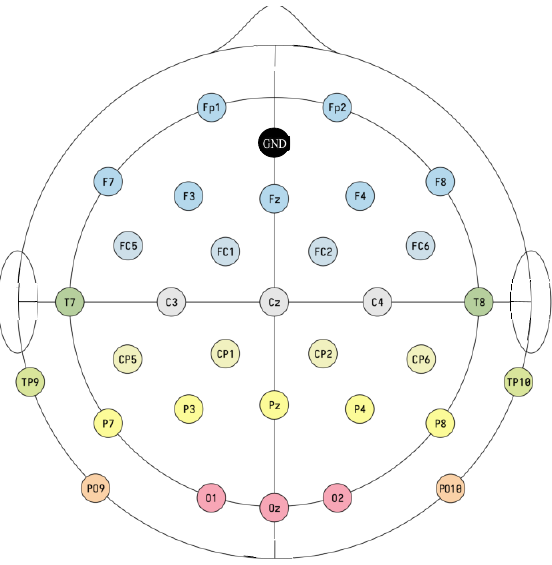
Figure 1. Electrode montage in the extended 10–20 system used in the experiments. All 32 channels plus GND. Cz is used as